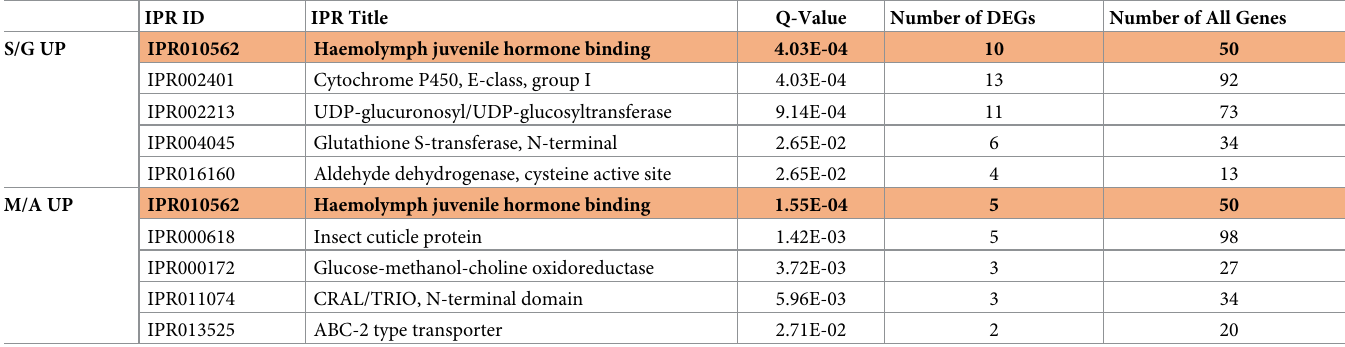
Table 1. Top 5 enriched IPR categories in up-regulated genes of S/G and M/A datasets.